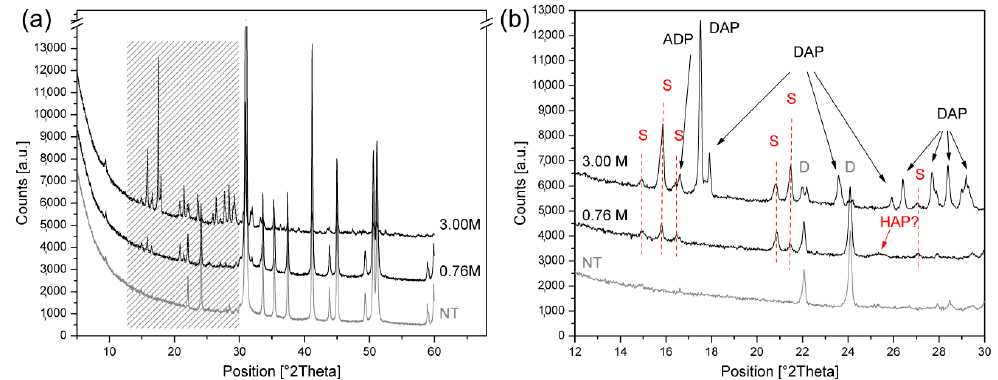
Figure 1. ( a ) X-ray powder diffraction(XRD) patterns of untreated Angera stone (NT) and Angera stone treated by poultice with 0.76 M and 3.00 M DAP solutions. ( b ) Detail in the range 12–30 ° showing the phase variations occurred after the consolidation. D = dolomite, S = struvite, HAP? = possible hydroxyapatite, DAP = diammonium hydrogen phosphate, ADP = ammonium dihydrogen